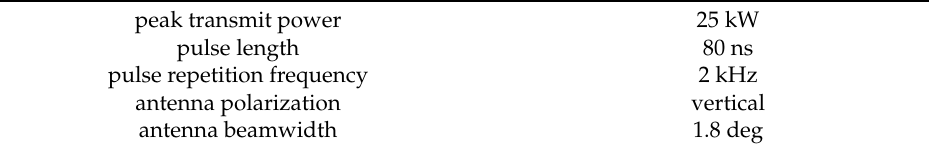
Table 1. Doppler radar parameters.